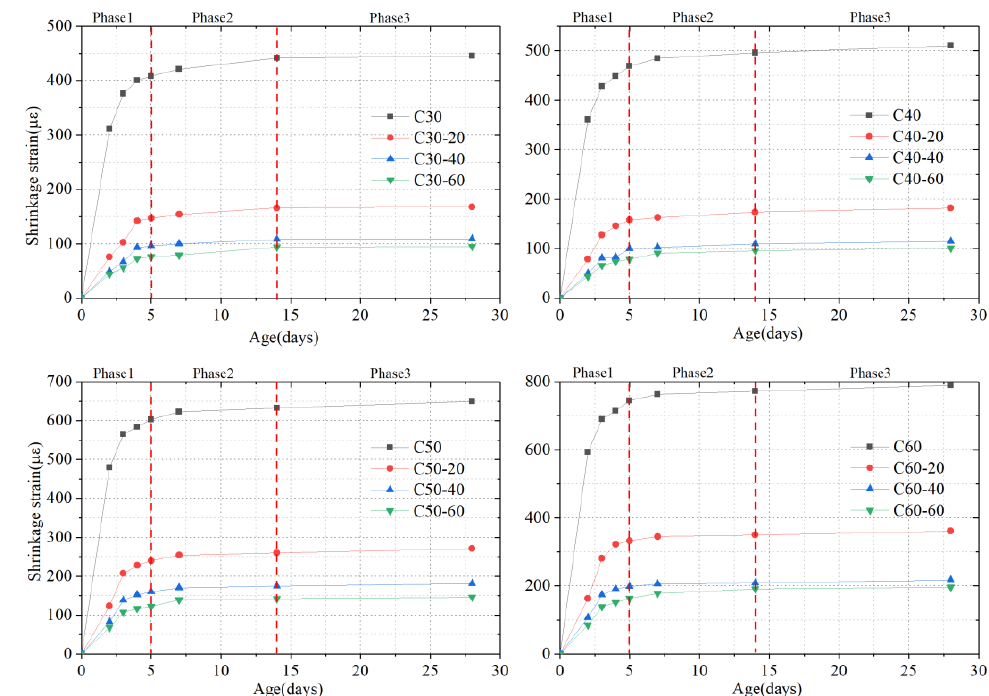
Figure 6. Concrete shrinkage curve changing with time.